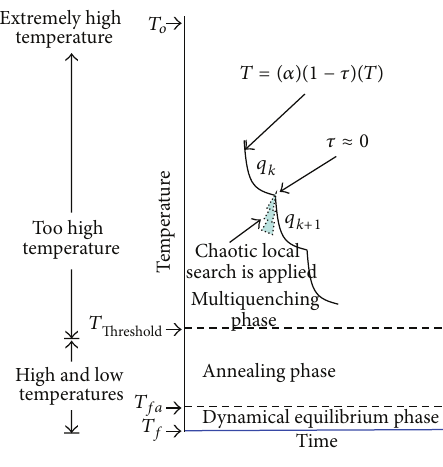
Figure 2: Chaotic local